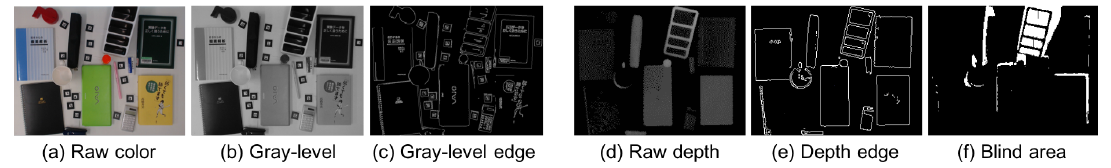
Figure 7. Intermediate images in feature